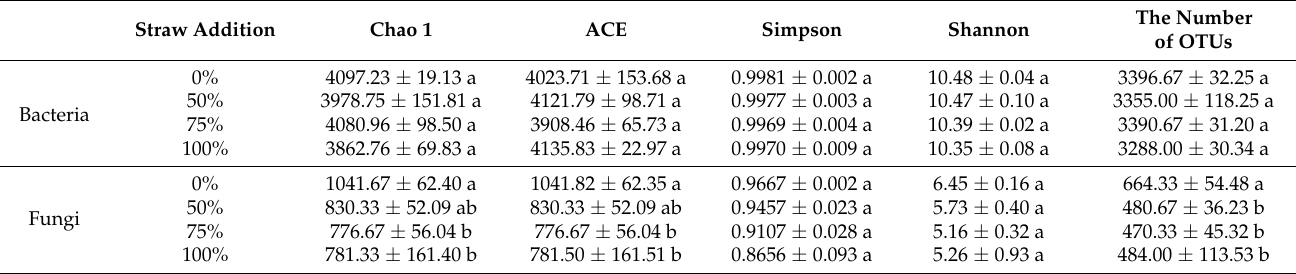
Table 1. Effects of rice straw addition on the alpha diversity indices of the bacterial and fungal communities. Straw Addition Chao 1 ACE